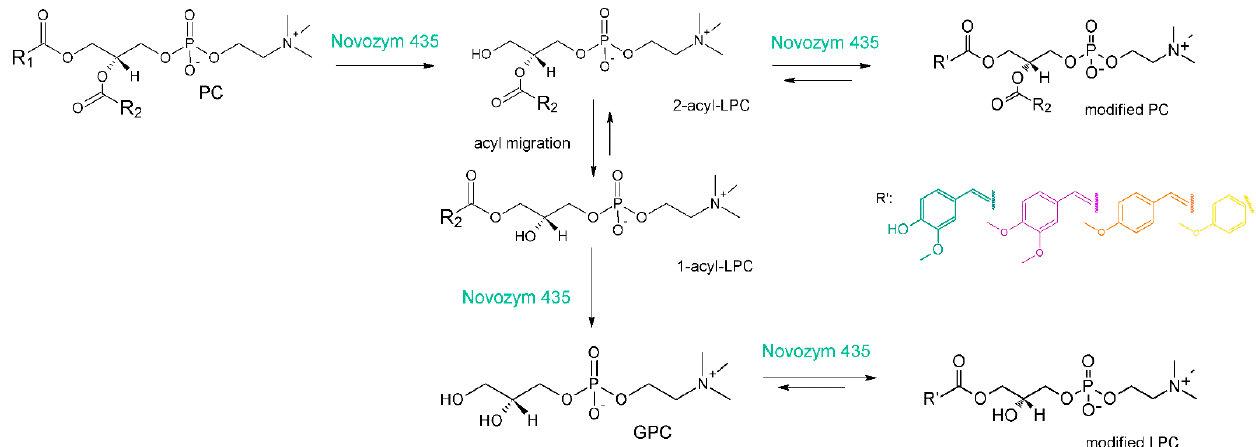
Figure 3. Possible pathway of the lipase-catalyzed synthesis of phenylated lysophospholips via acidolysis/transesterification reaction.